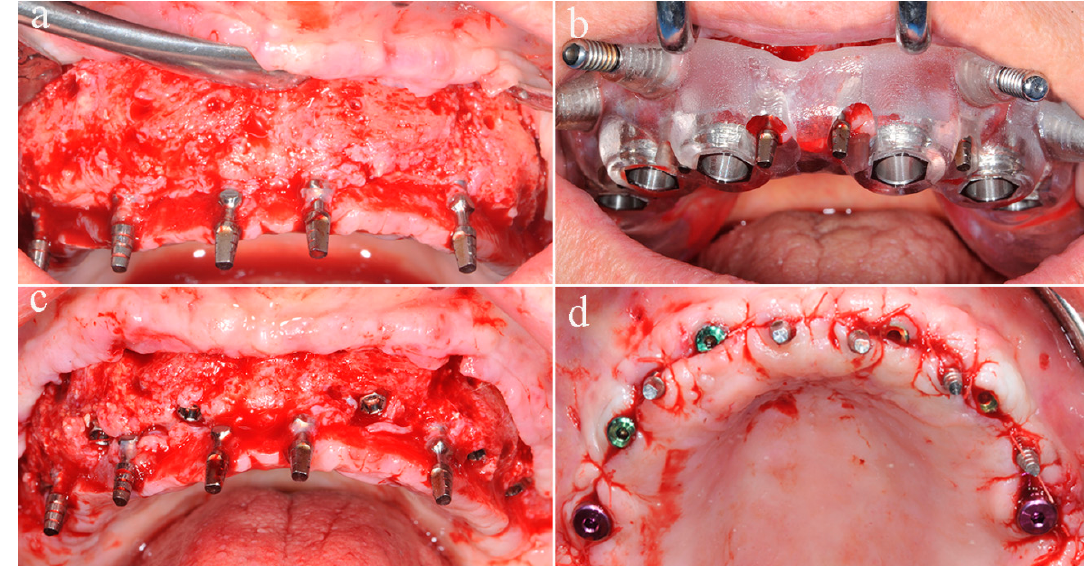
Figure 3. Implants insertion: ( a ) exposition of the grafted maxillary buccal surface after the mucoperiosteal flap elevation and screws removal; ( b ) stereolithographic surgical template in place; ( c ) six implants positioned at planning sites; ( d ) the flap repositioned and sutured around healing abutments.